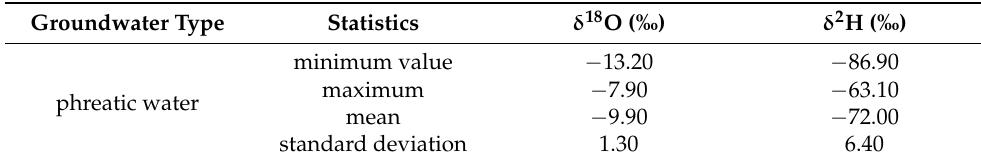
Table 4. Statistics of stable isotopes of hydrogen and oxygen in